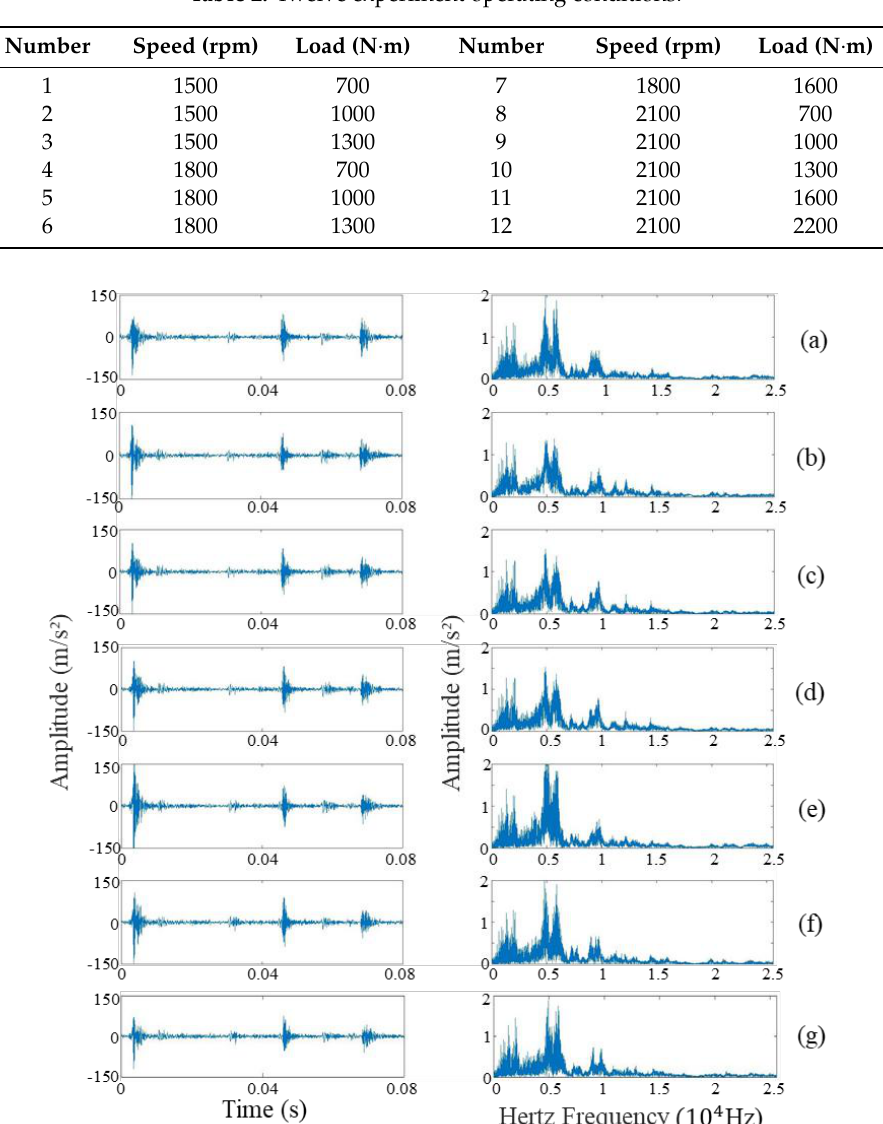
Figure 2. Original vibration signals of seven valve clearance states and corresponding frequency spectrums: ( a ) NVC, ( b ) SFI, ( c ) LFI, ( d ) SFE, ( e ) LFE, ( f ) SFIE, ( g ) LFIE.